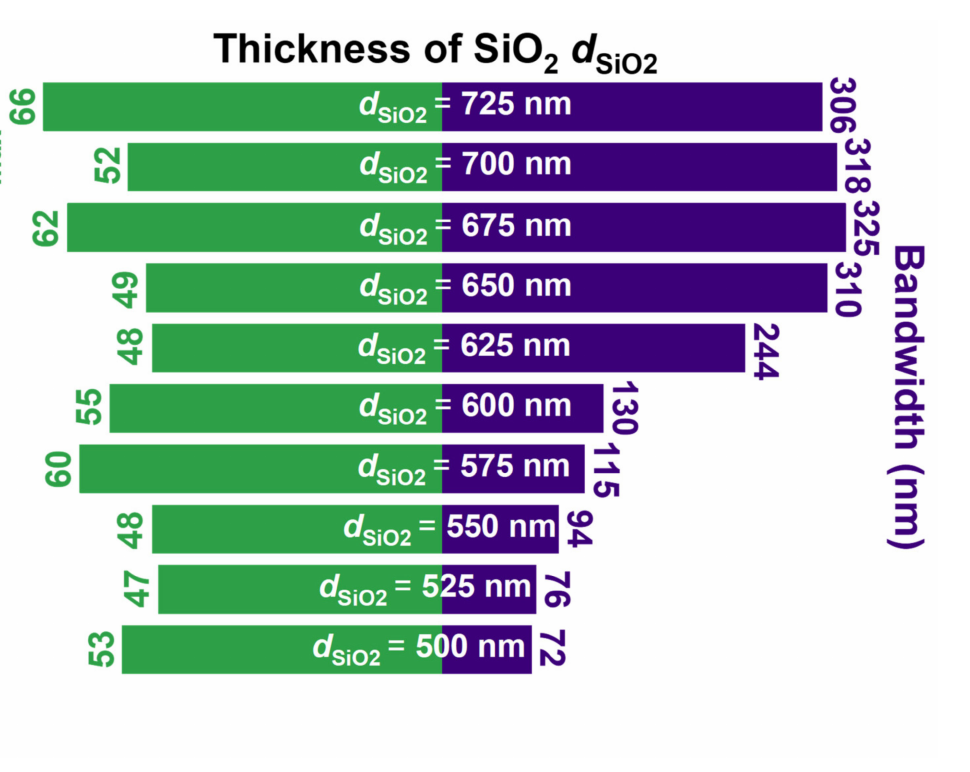
Figure A4. The bandwidth and the maximum extinction ratio ER max within the corresponding wavelength region at the thickness of SiO 2 d SiO from 725 to 500 nm with the interval of 25 nm. 2 For separating p light at specific wavelength, the ER max shares the same trend as the bandwidth in Figure A5, and the ER max at the SiO 2 ’s thickness of 675 nm is the highest as a